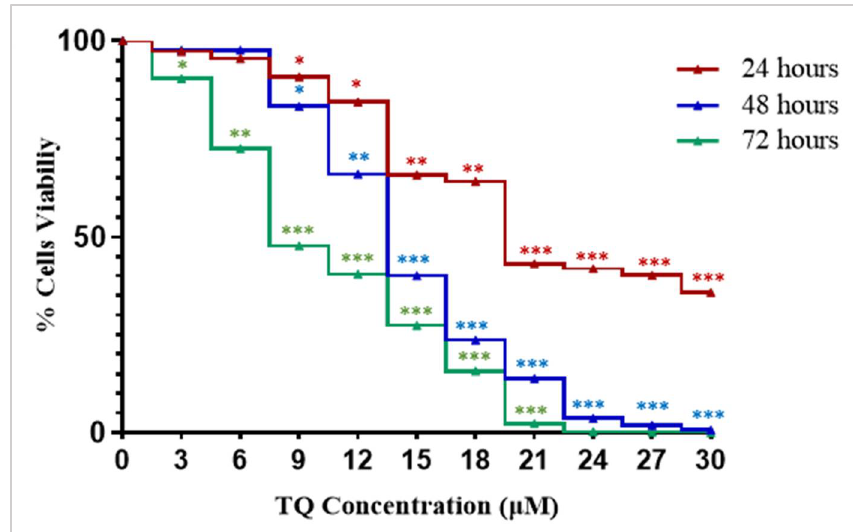
Figure 1. TQ’s dose and time-dependent inhibitory effects on the proliferation of K562 cells. The WST-8 assay was used to assess the cytotoxicity effects of TQ at different concentrations (3 μM, 6 μM, 9 μM, 12 μM, 15 μM, 18 μM, 21 μM, 24 μM, 27 μM, and 30 μM) on K562 cells after 24 h, 48 h, and 72 h of treatment, the IC 50 values were 23 μM, 15 μM, and 11 μM, respectively. Wilcoxon signed ranks test was conducted and the results are stated as the median of four independent experiments, * p < 0.05, ** p < 0.01, and *** p < 0.001 are significant versus untreated control cells.